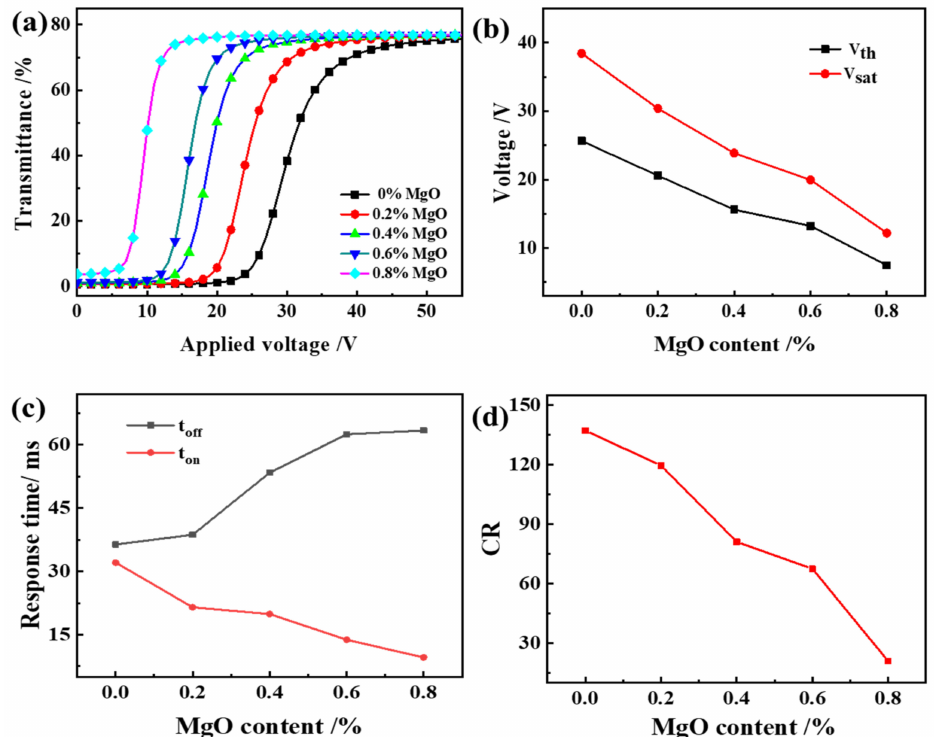
Figure 8. The effect of MgO content on the electro-optical properties of PDLC ( a ) applied electric field (100 Hz) dependence of the transmittance of samples c1~c5; ( b ) V th and V sat of samples c1~c5; ( c ) Response time of samples c1~c5; ( d ) CR of samples